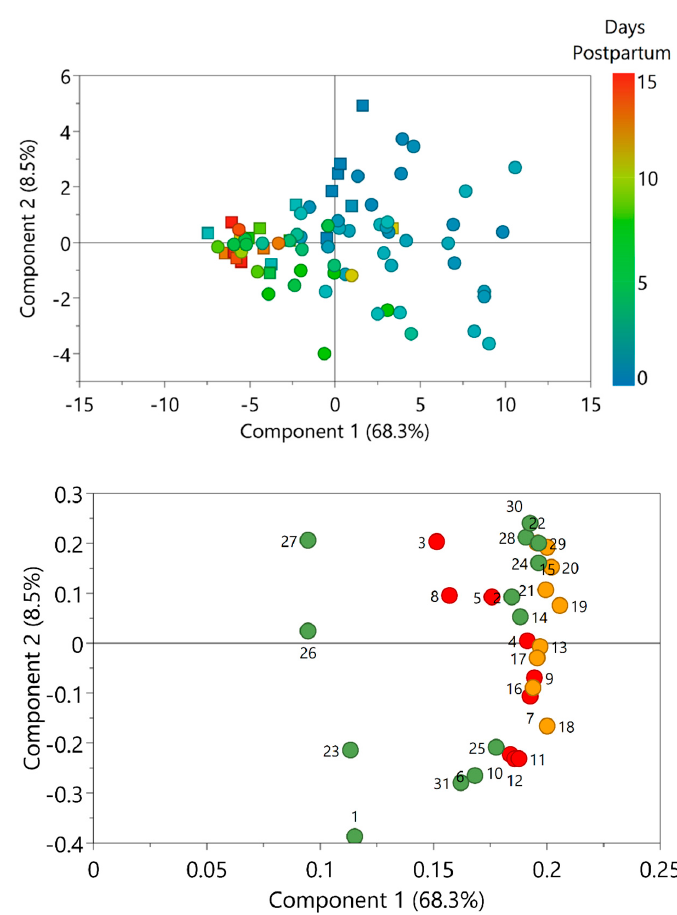
Figure 2. ( A ) PCA score scatter plot of preterm milk (squares) and term milk (circles) expressed between day 1 and 15 weeks post-partum. Score colours indicate day postpartum at which the samples were expressed. ( B ) Corresponding loading scatter plot containing the 31 phospholipid species quantified in human milk belonging to the phospholipid classes phosphatidylethanolamine (red circles), phosphatidylcholine (orange circles) and sphingomyelin (green circles). Details about the numbering of phospholipid species can be found in Table